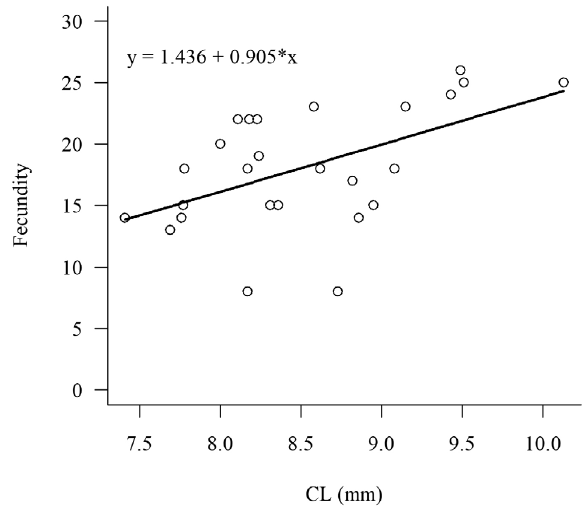
Figure 4. Macrobrachium jelskii (Miers, 1877). Relationship between the maximum number of eggs from each female (fecundity) and the carapace length